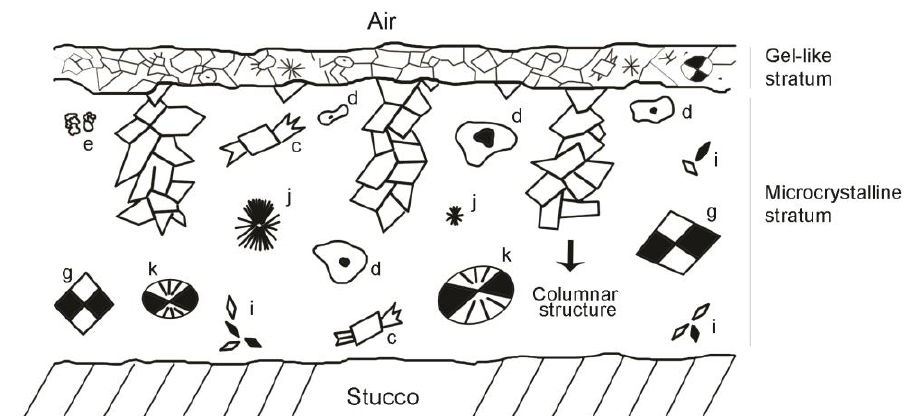
Figure 3. Sketch of the epigenetic superficial film in section. Letters correspond to the crystalline phases and other particles shown in Figure 2 (modified from [29]). Note that although the gel-like stratum is mainly composed of sub-micron particles of calcium carbonate (vide infra) , some of the crystallochemical phases identified in the microcrystalline stratum may be also present in the outermost layer. Letters correspond to crystalline specimens and other particles shown in Figure 2.